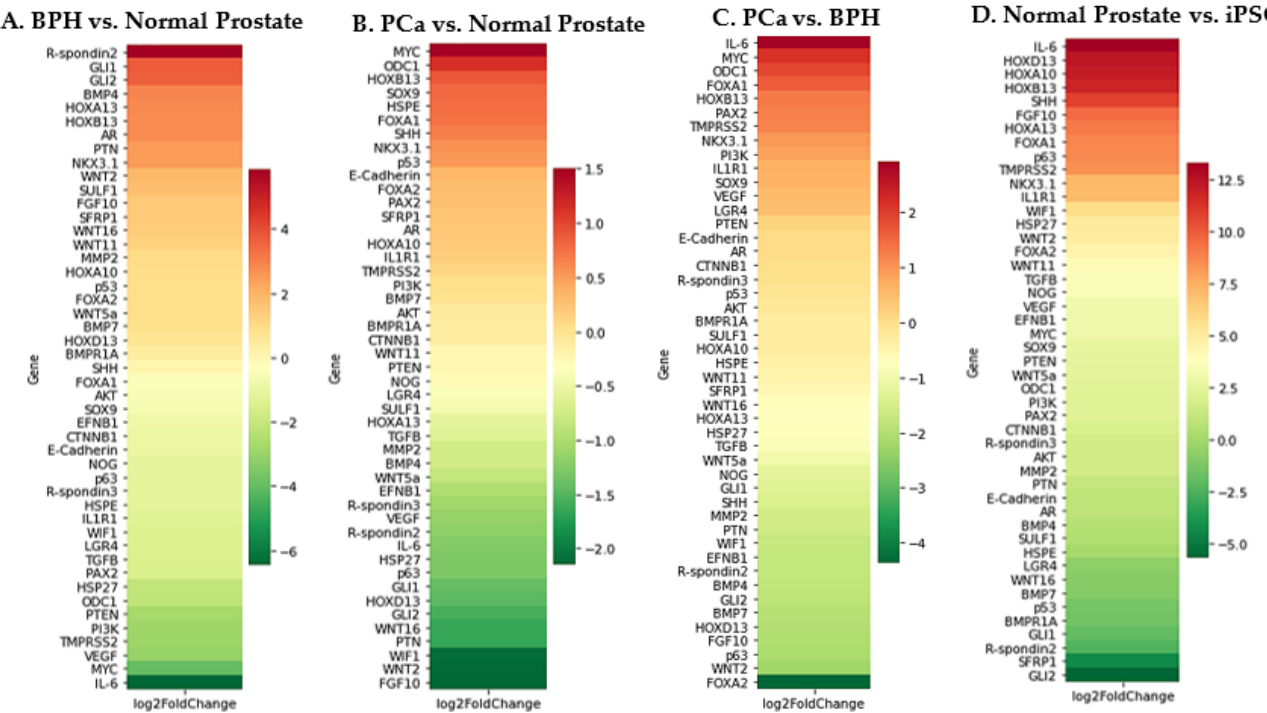
Figure 2. Expression levels of key developmental genes. ( A ) BPH vs. normal prostate; ( B ) cancer vs. normal prostate; ( C ) cancer vs. BPH; ( D ) normal prostate vs. iPSC. Red: upregulated; green: downregulated.